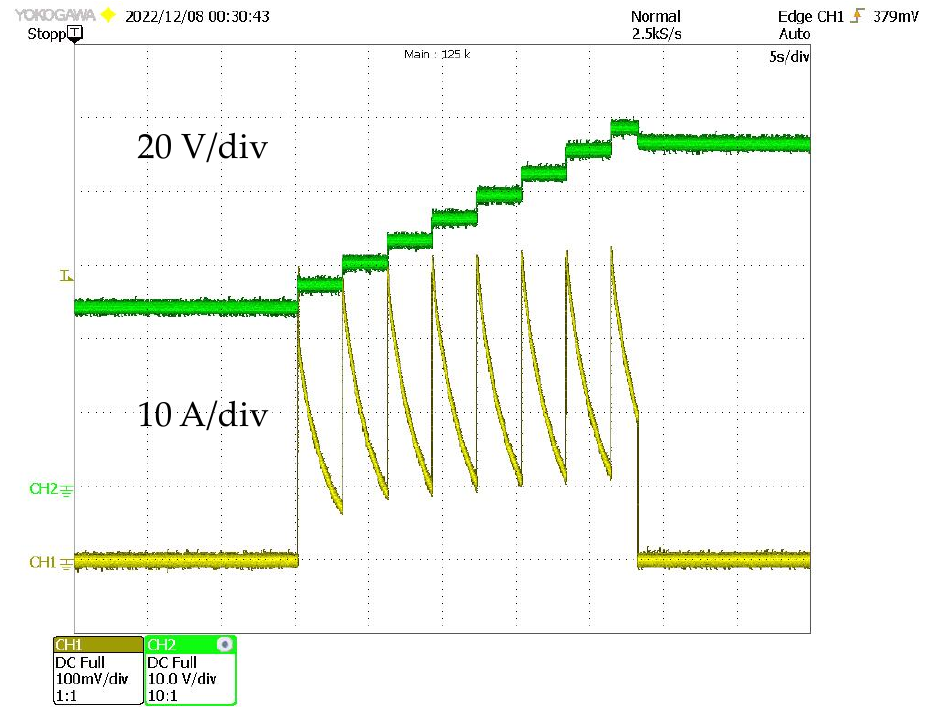
Figure 38. Experimentally obtained diagrams of charging voltage and current.